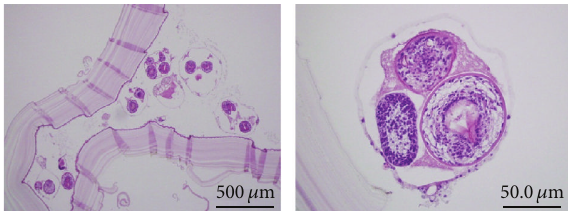
Figure 5: Microscopic examination revealed the presence of proto- scolices in the fluid of the daughter cysts, which is characteristic of Echinococcus granulosus